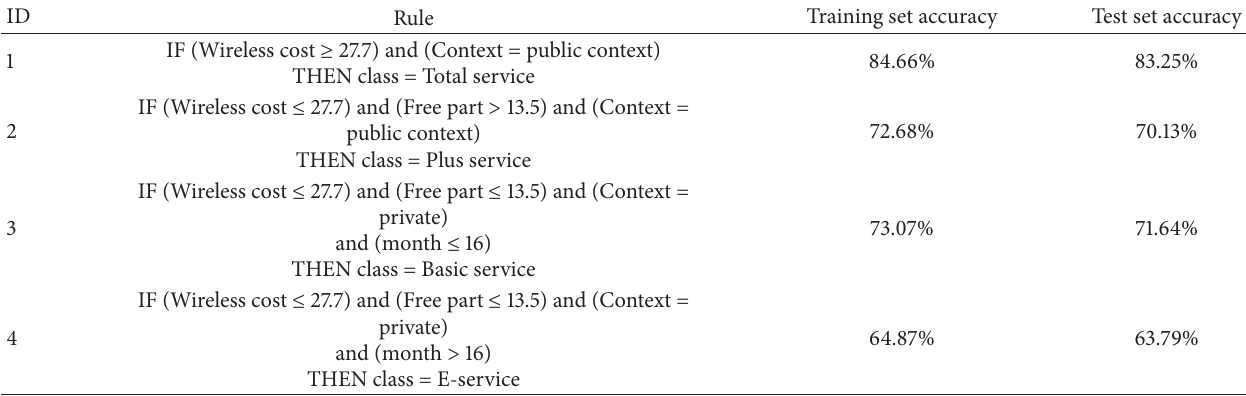
Table 3: Rules on mobile users generated by the algorithm.